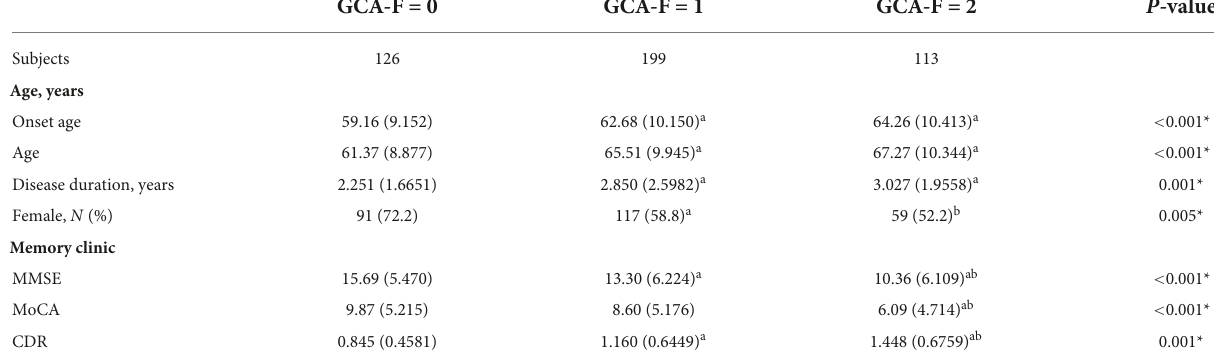
TABLE 4 Demographic features and GCA-F scale of the samples.